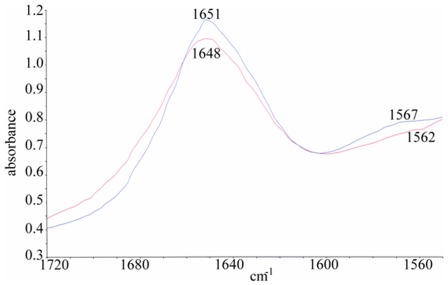
FT- IR spectra of free HSA (blue) and HSA -virstatin complex (red) in D2O in the range of 1720 to 1560 cm−1
.